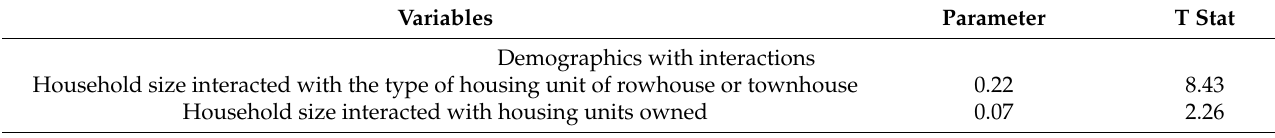
Table 4. Ordered response model of residential choice of housing density at census block